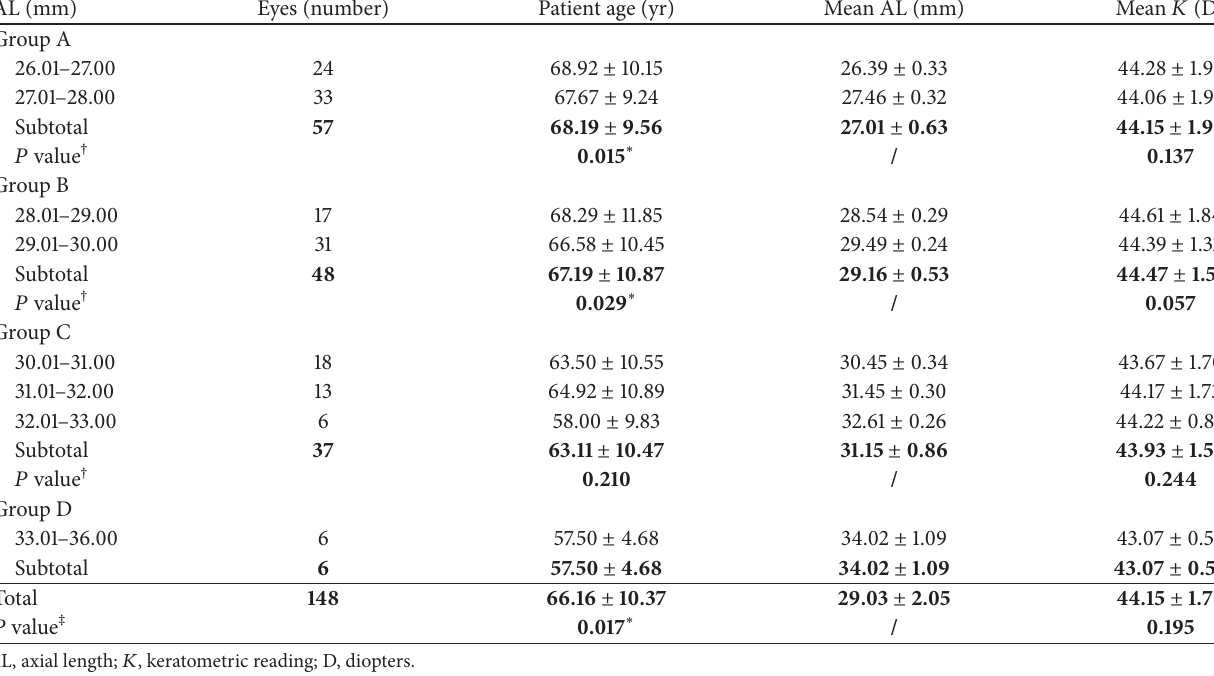
Table 1: Baseline characteristics of eyes included in the study.